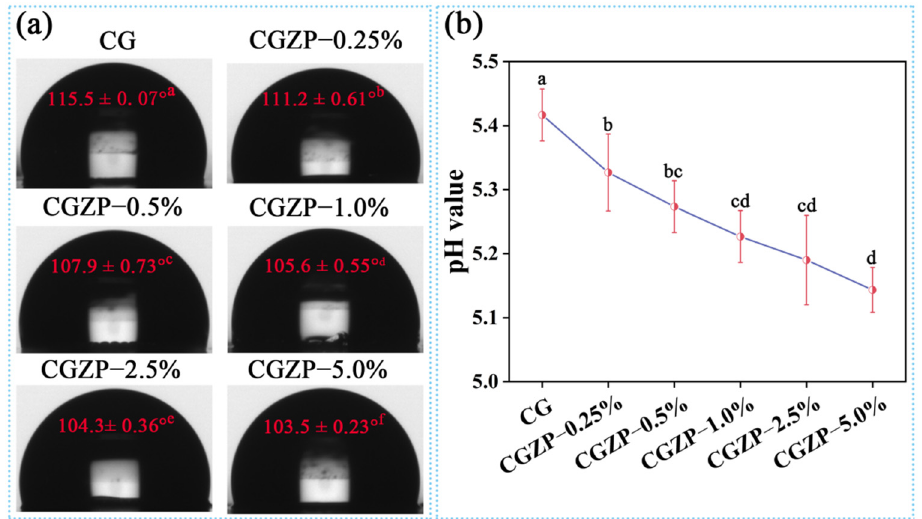
Figure 4. WCA ( a ) and pH ( b ) value of CG and CGZP films. Different letters in each figure indicate significant differences ( p < 0.05).